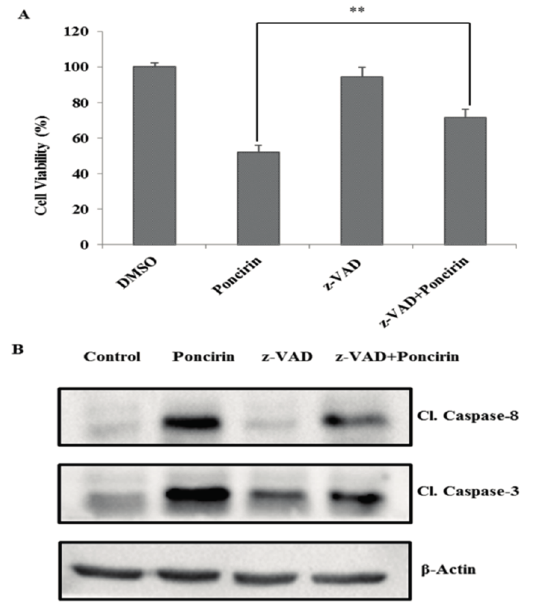
Figure 4. Activation of caspases, subsequent cleavage of PARP and up-regulation of Fas ligand in the Poncirin treated AGS cells. AGS cells were incubated at indicated concentrations of Poncirin for 24 h. Western blot analysis was conducted to determine the effects of Poncirin on the caspase activation, and PARP cleavage and Fas ligand up-regulation was measured by protein expression. β -Actin served as a loading control (* p < 0.05 and ** p < 0.01 vs. control